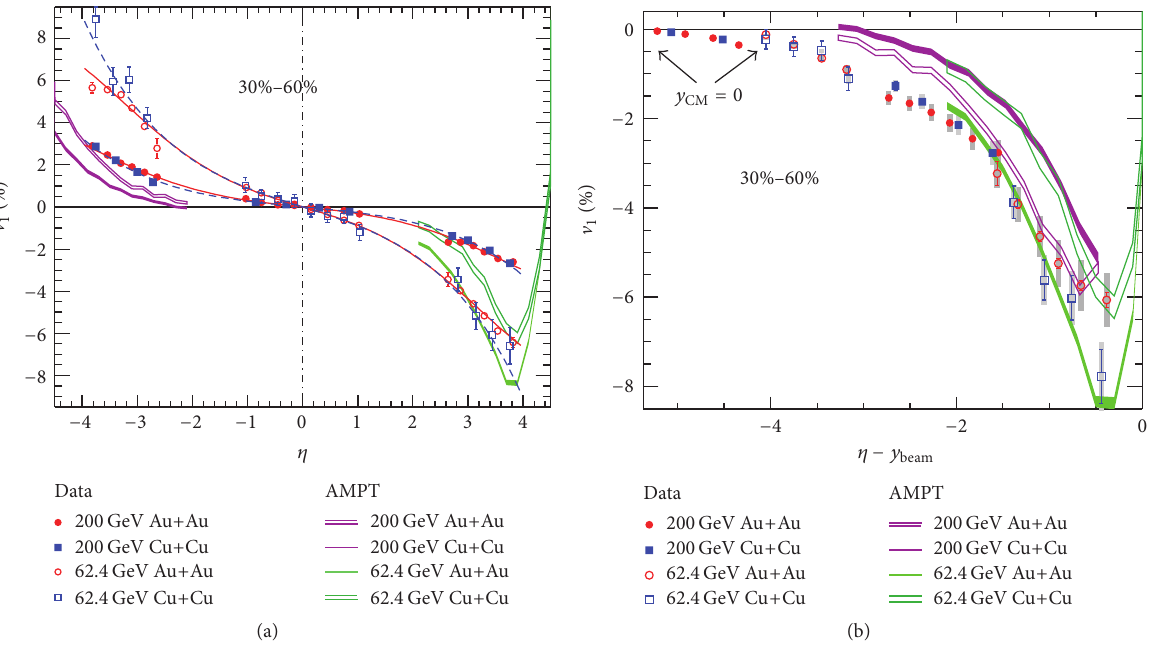
Figure 3: (a) Charged particle V 1 as a function of 𝜂 for 200 and 62.4 GeV Au+Au and Cu+Cu collisions [44]. (b) is the same as (a), but with the 𝑥 -axis shifted by 𝑦 beam